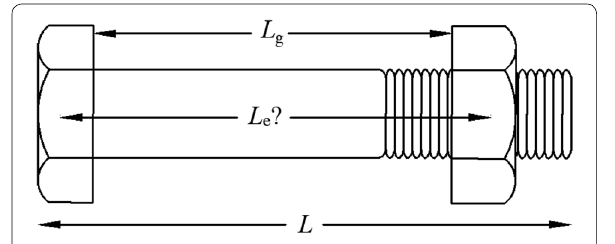
Figure 13 Model of axially loaded bolt [48] Figure 14 Example of a mechanical bolt assembly